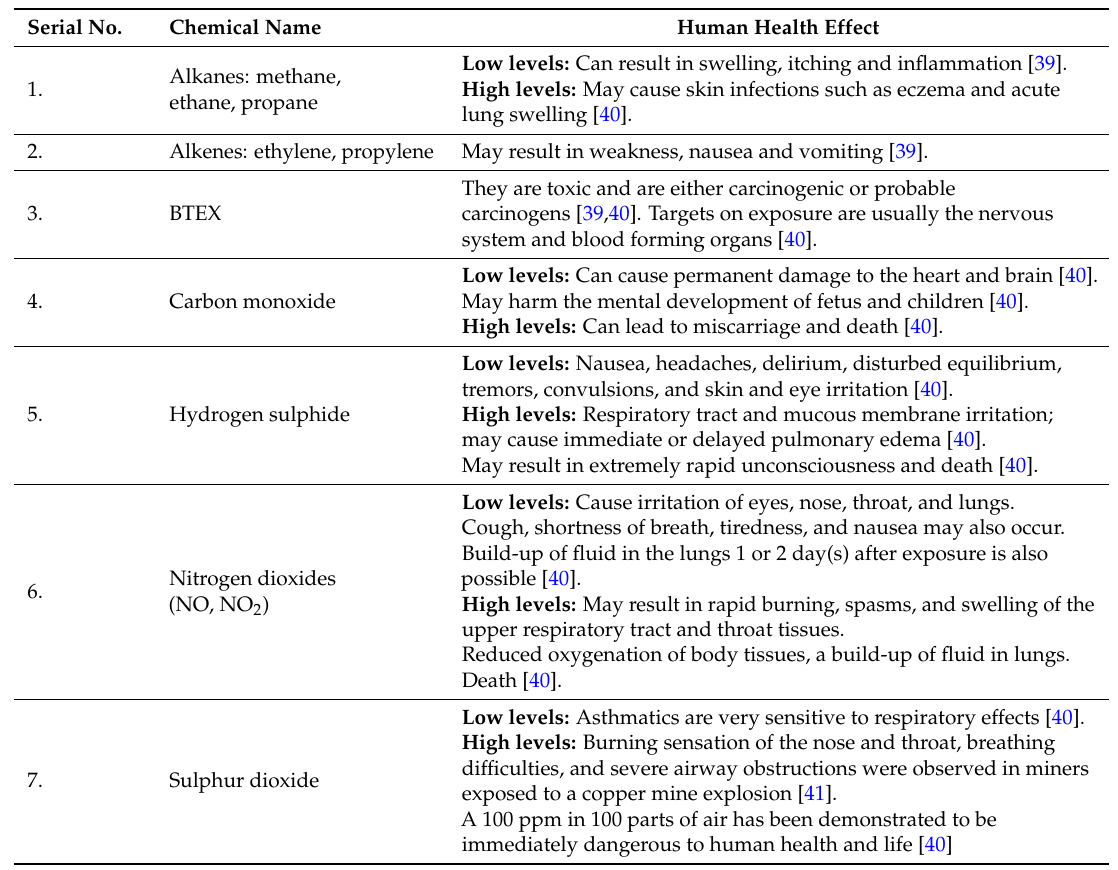
Table 1. Some human health effects of gas flare pollutants in the Niger